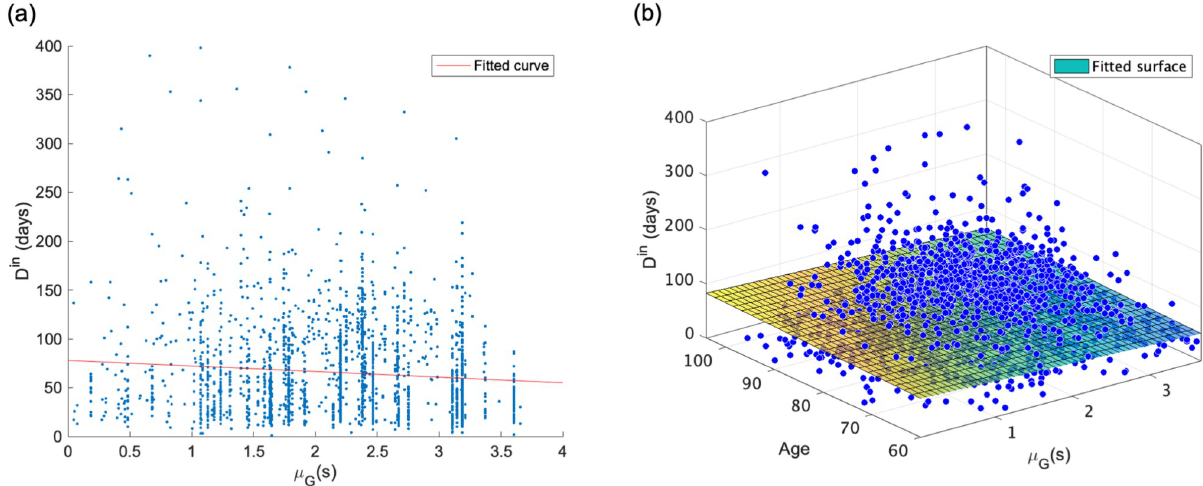
Fig 6. Result of linear regression model with duration of hospital stay D in as output variable and geometric mean of strength μ G ( s ) and age as input variables. (a) D in vs.